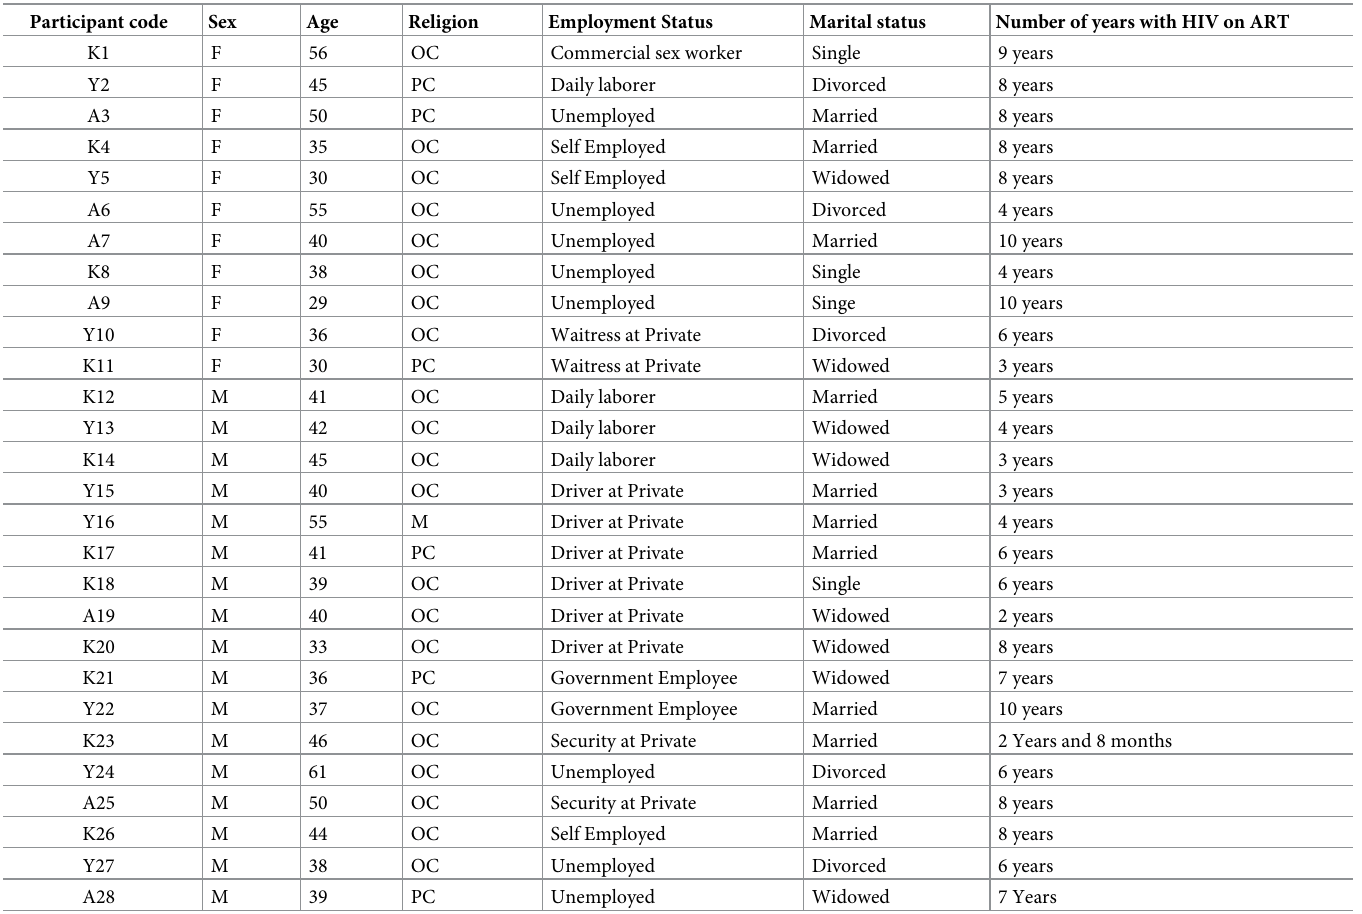
Table 1. Socio-demographic characteristics of research